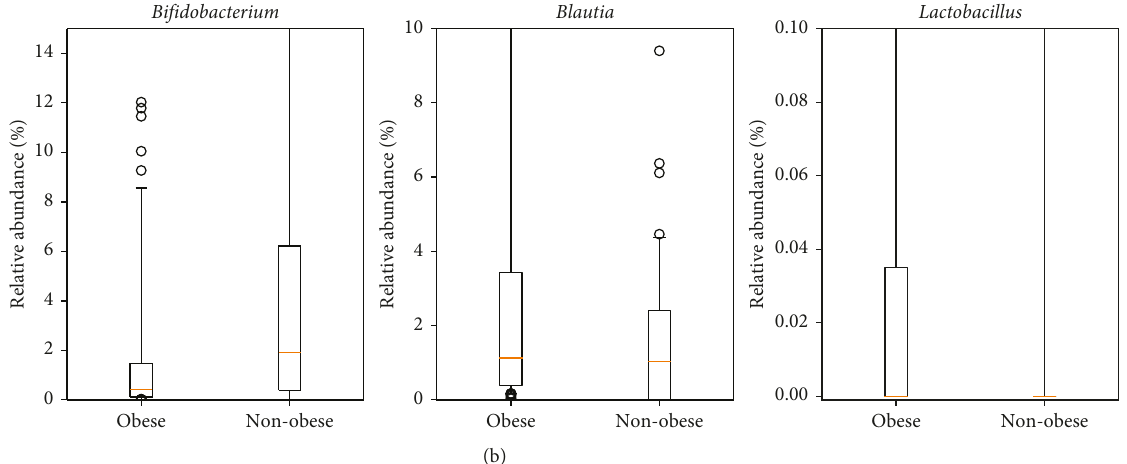
Figure 2: The relative abundance of bacterial compositions in obese and nonobese children at the phylum and family levels is shown in (a). The inner circle demonstrates the composition at the phylum level, and the outer circle demonstrates the composition at the family level. In the obese children, the most abundant bacterial population at the phylum level was Firmicutes (47.1%). In the nonobese children, the dominant gut bacteria contained Firmicutes and Bacteroidetes of about 46.0%. The obese children contained significantly lower numbers of Bacteroidetes and Actinobacteria than nonobese controls ( P < 0 . 001, Wilcoxon rank-sum test). Obese children showed a greater average proportion of Proteobacteria and Fusobacteria than nonobese children ( P < 0 . 001). No significant difference in Firmicutes was observed between obese and nonobese children. The compositional differences in obese and nonobese children at the genus level are shown in (b). Orange lines indicate the median, and black boxes indicate the 1 st –3 rd interquartile range. Whiskers extend beyond the interquartile range by 1.5 times, starting from Q1 − 1 . 5 ∗ ( Q3 − Q1 ) to Q3 + 1 . 5 ∗ ( Q3 − Q1 ) . Black circles indicate individual outlying data points. The relative abundance of Bifidobacterium was significantly higher in the nonobese children than in the obese children ( P < 0 . 0001), but Blautia and Lactobacillus in the nonobese children were significantly lower than those in the obese children ( P � 0 . 0035 and P � 0 .